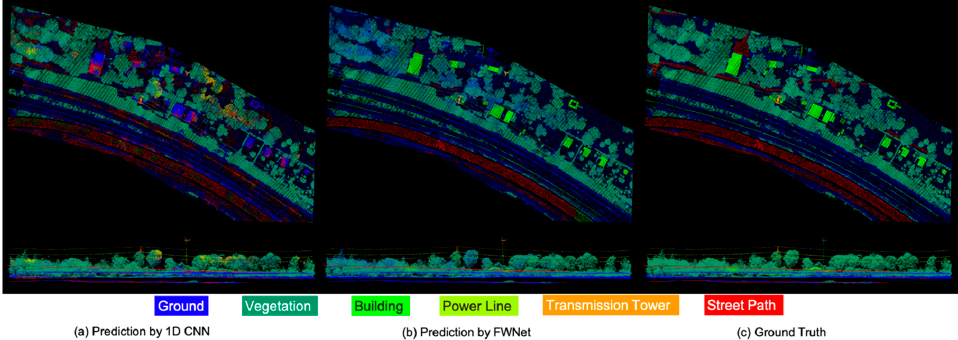
Figure 9. Predicted results of the test data.